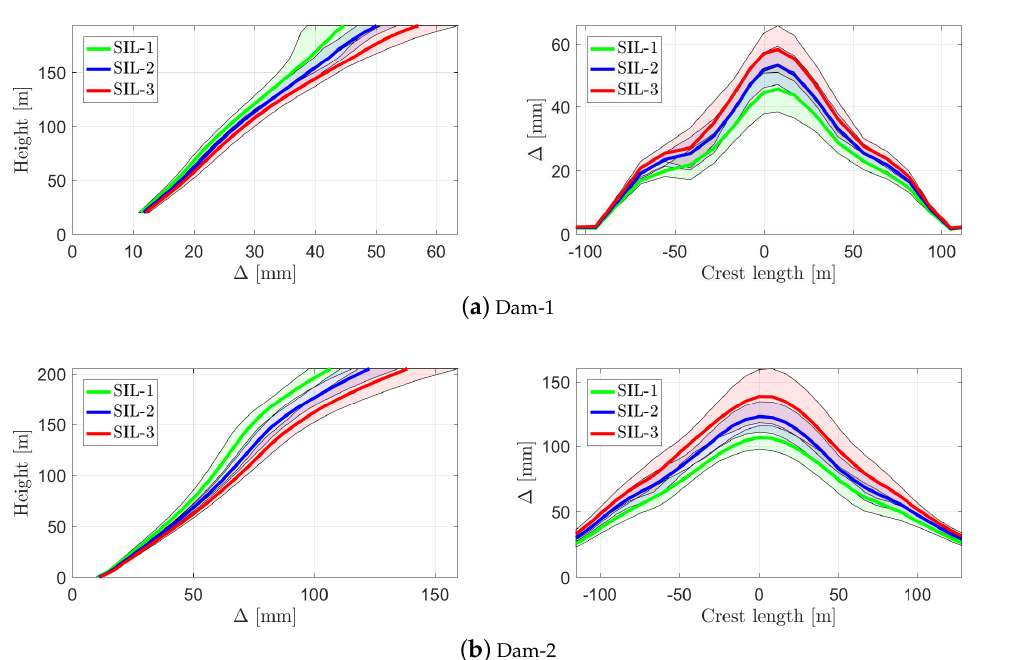
Figure 4. ( a , b ) Maximum displacement response of arch dams subjected to three seismic intensity